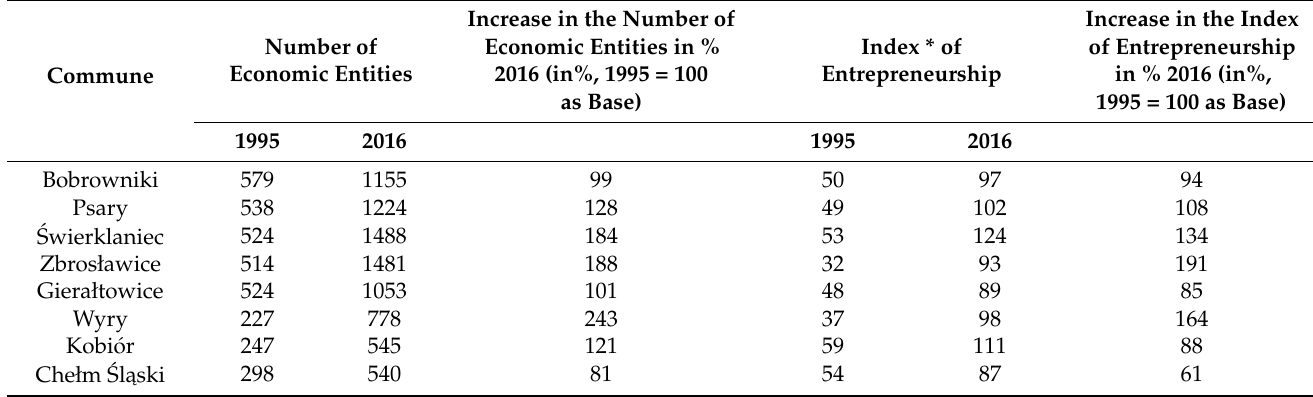
Table 5. Number of business entities in the researched rural communes in 1995 and 2016. Increase in the Number Commune